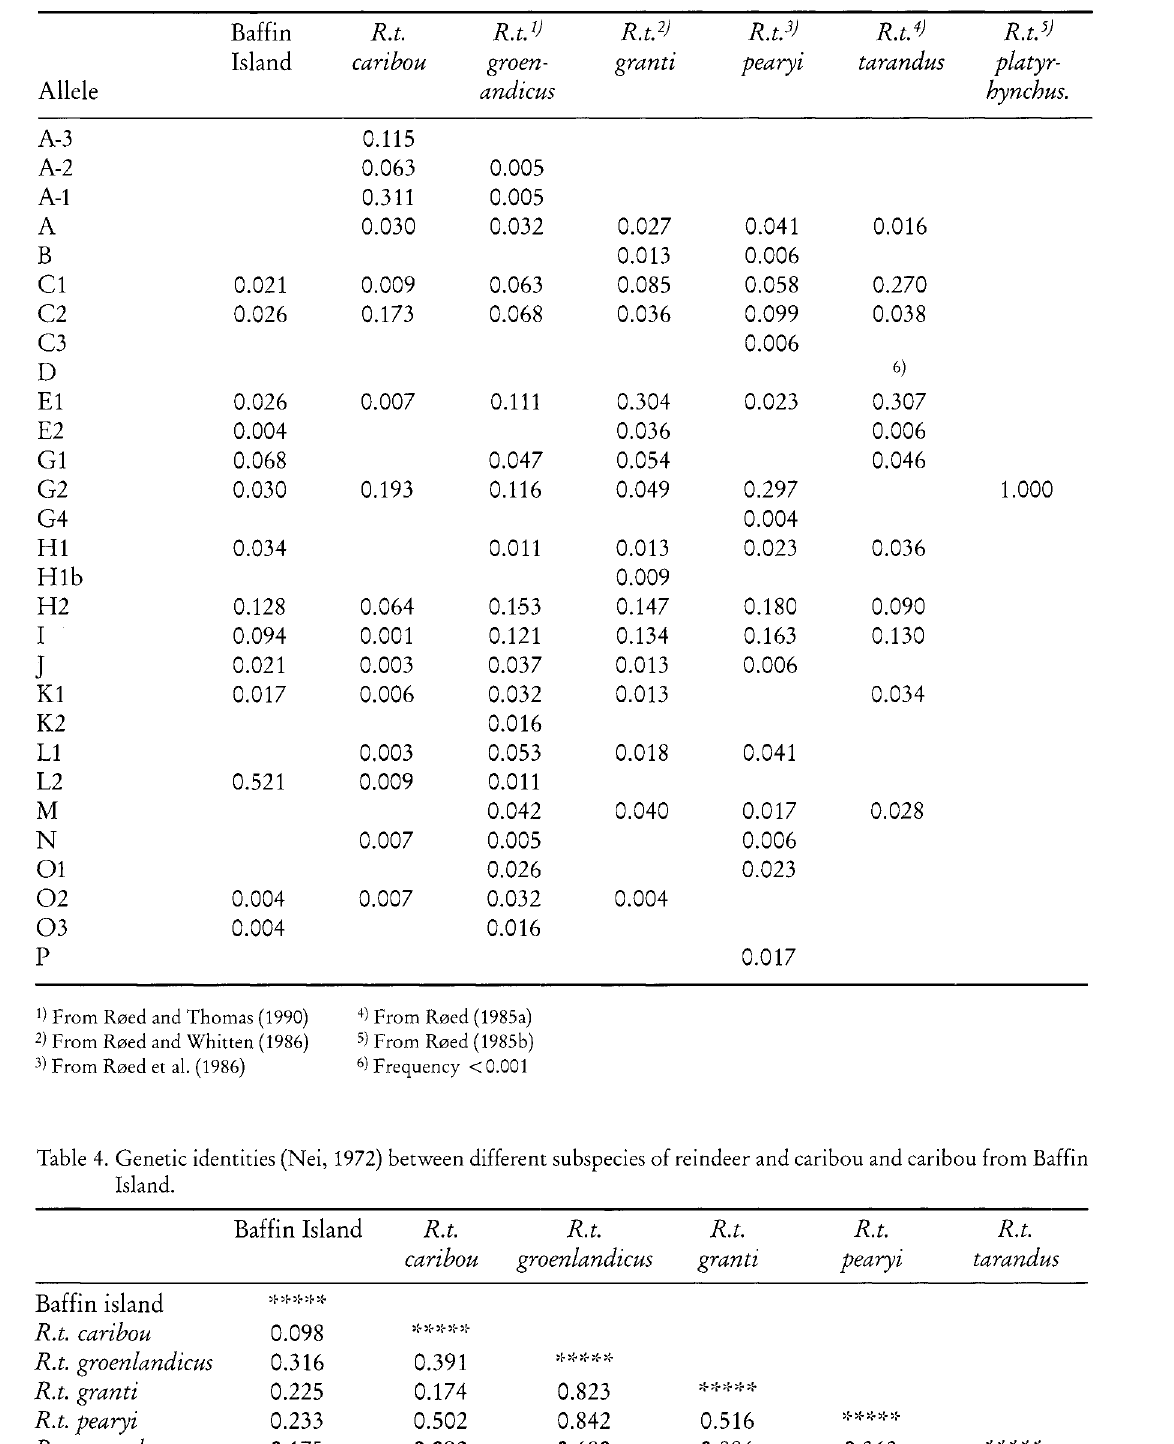
Table 3. Transferrin allele frequencies in Baffin caribou and in different subspecies of reindeer/caribou.